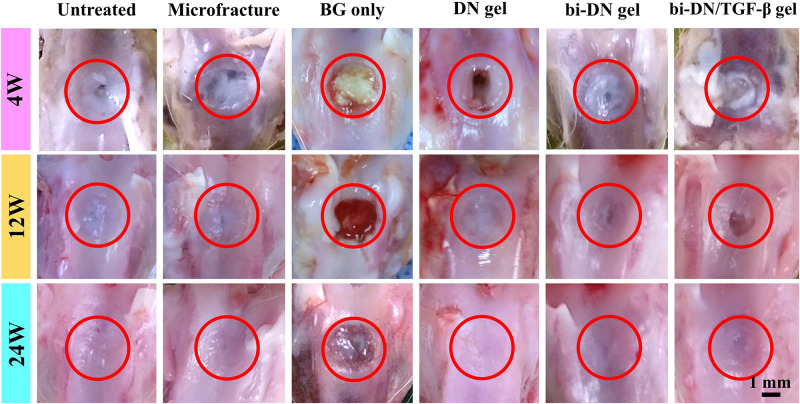
Gross observation of defect surface at 4, 12, and 24 weeks after surgery. The defect areas were highlighted by red circles (BG, bioactive glass; DN gel, GC/Alg double network hydrogel; bi-DN gel, double-layered DN gel).